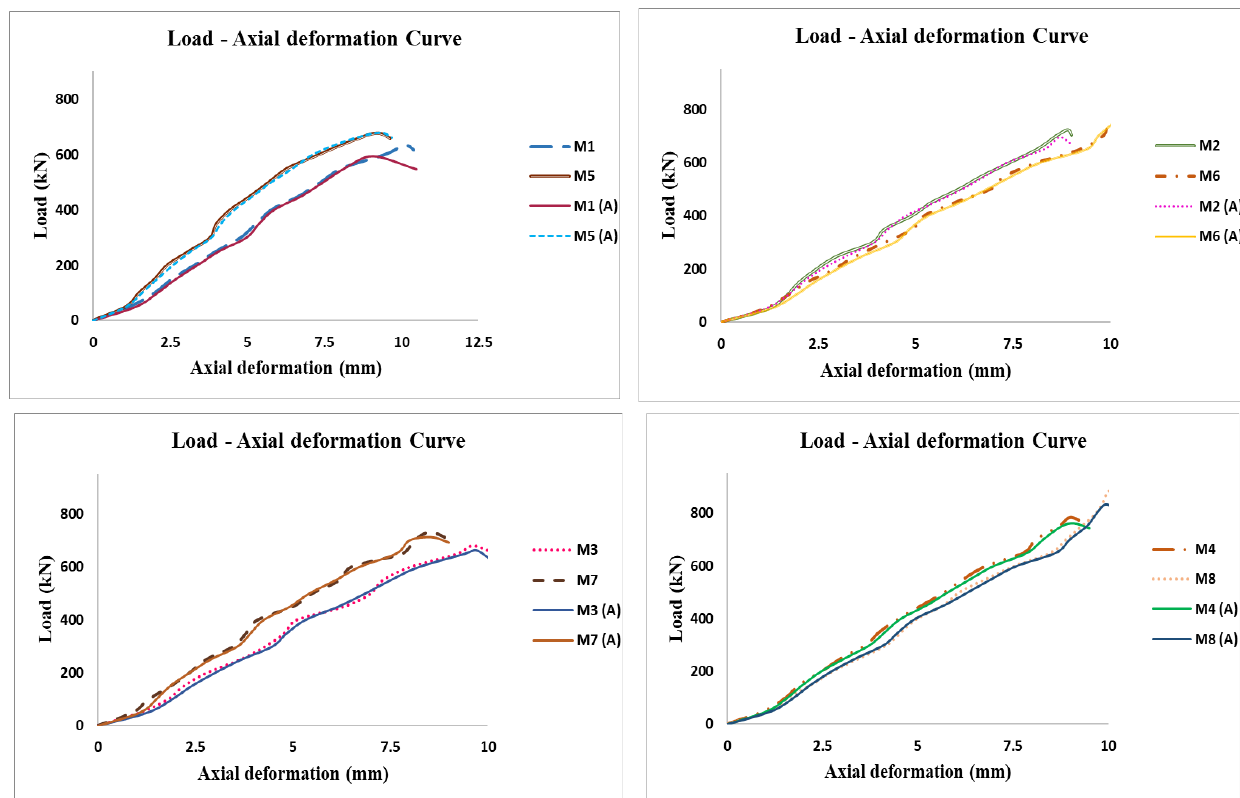
Figure 17. Load vs. axial deformation curves of self-stressed columns for the impact of PVA fibers.